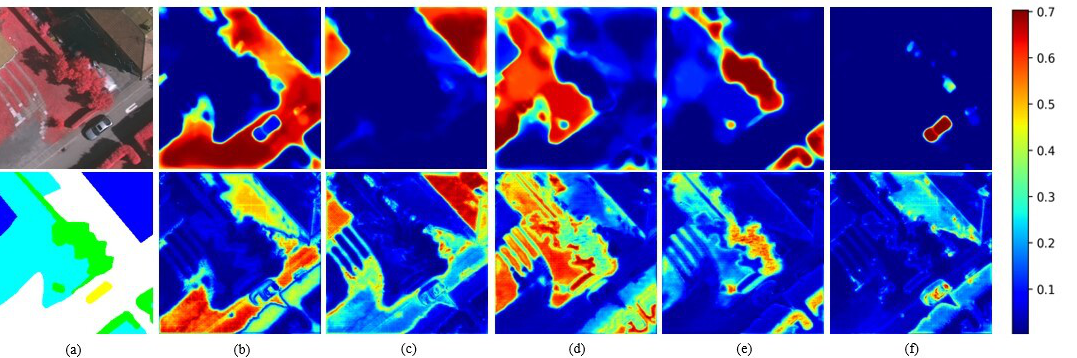
Figure 15. The effect of baseline network on the remote sensing semantic segmentation results. ( a ) is the input image and ground truth, and ( b – f ) are different types of surface feature attention